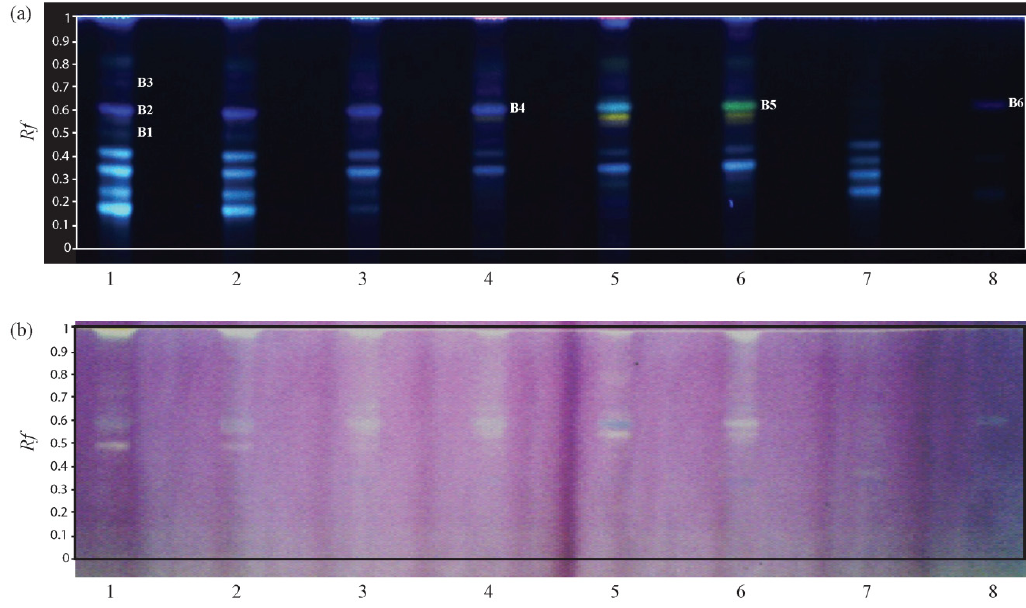
Track 8: purified 5-methoxy-4',7-trihydroxy-8-glucopyranosylisoflavone ( a )